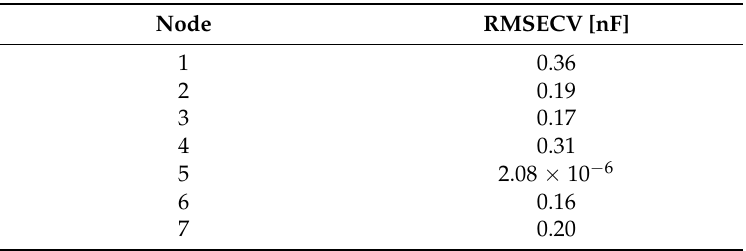
Table 4. Root-mean-square error in cross validation (RMSECV) in the identification of the capacitance shifts (from C1 to C7), as obtained from the partial least square discriminant analysis (PLS-DA) model by using the leave-one-out cross-validation criterion. Each row of the table reports the node (the point of observation for monitoring the ‘sensor’ variation) in the first column and the minimum detectable variation in that node, in the second